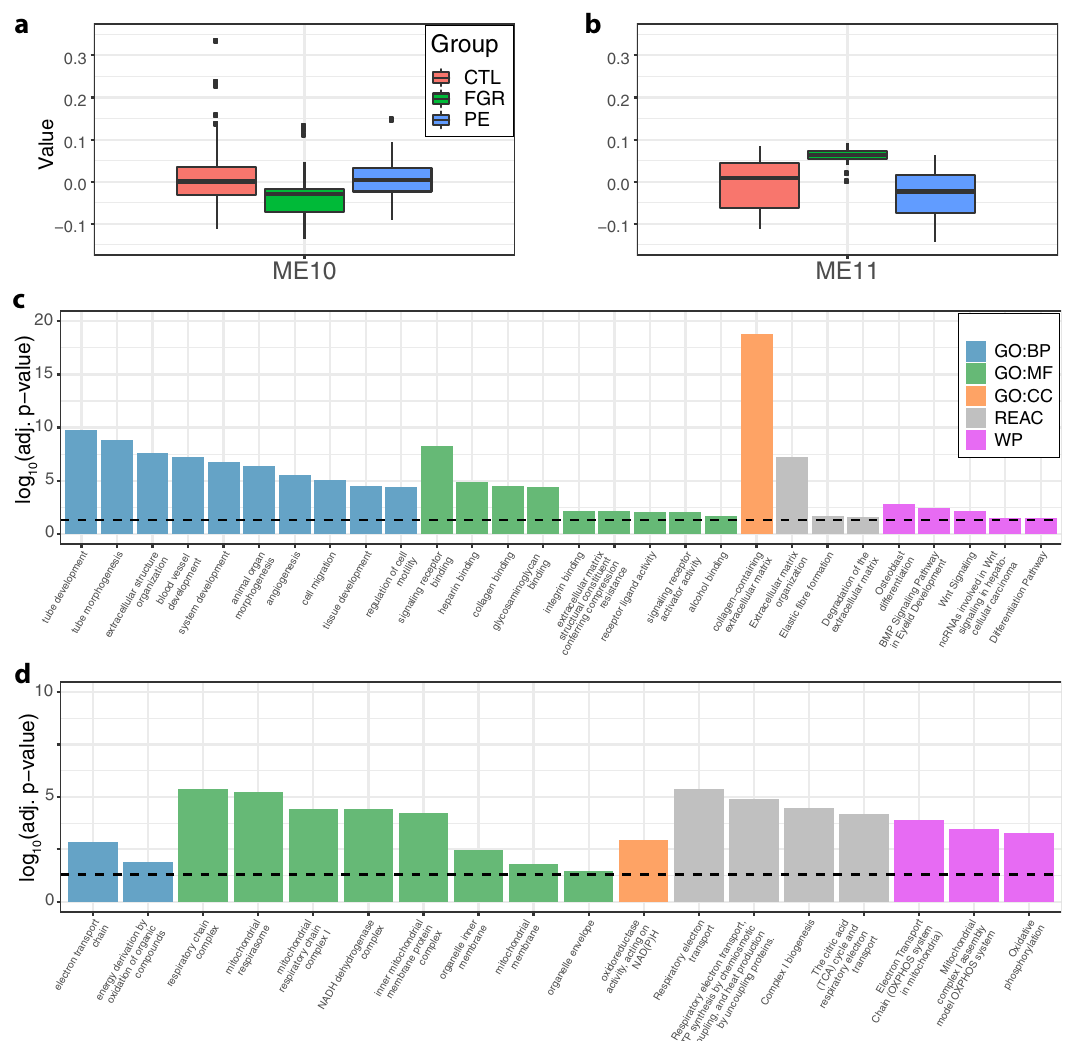
Fig. 4 Characterization of miRNA-enriched WGCNA network modules 10 and 11. The eigengene summarizing the transcripts in ( a ) module 10 was associated with FGR ( q -value = 5.8 × 10 − 5 ); and ( b ) module 11 was associated with both FGR ( q -value = 1.8 × 10 − 7 ; 52 cases and 148 controls) and PE ( q -value = 1.1 × 10 − 3 ; 88 cases and 148 controls). The q -values were calculated using the ‘ qvalue ’ Bioconductor package to control the local false discovery rate at the 0.05 level. Signi fi cantly overrepresented Gene Ontology (GO, biological process BP; molecular function MF; and cellular component CC), Reactome (REAC), and WikiPathways (WP) terms are shown for (c) module 10; and (d) module 11. For clarity, only GO terms with a shortest root-to-node path of length 4 are shown, and at most, the top 10 hits within each sub-ontology are shown. The enrichment analyses were performed using the R interface to g:Pro fi ler, and adopting the g:SCS correction to control for multiple testing with threshold P = 0.05. All statistical tests were two-sided. Full results are provided in Supplementary Data 28 – 74. In ( a and b ), the boxes show the median and the lower and upper quartiles. The whiskers extend from the lowest observed point still within 1.5 times IQR (the interquartile range) of the lower quartile, to the highest observed point still within 1.5 times IQR of the upper quartile. All points beyond the whiskers are plotted as